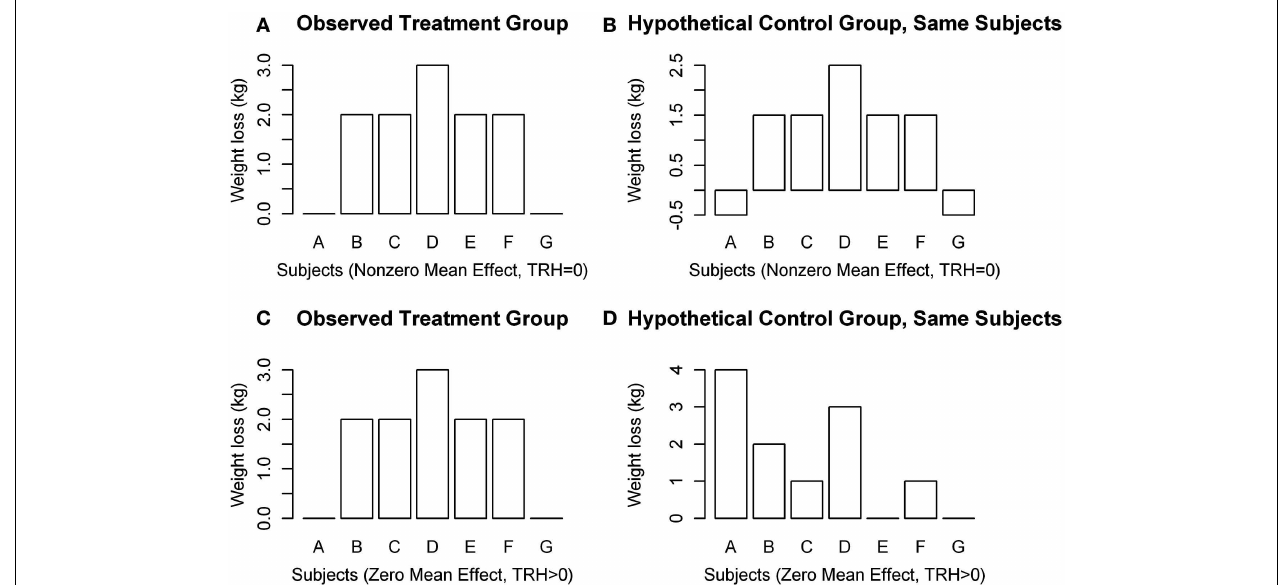
FIGURE 1 | Hypothetical distributions of individual weight changes in a clinical trial. (A,B) Show µ D (cid:54)= 0,TRH = 0, and (C,D) show µ D = 0,TRH > 0.